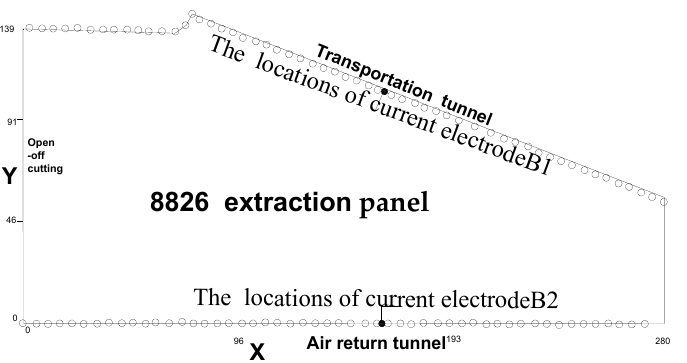
Figure 3. Layout plan of the electrodes; The black circle is the current electrode B; The circle of the return air roadway is the current electrodes A1; The circle in the transport roadway is the current electrodes A2.